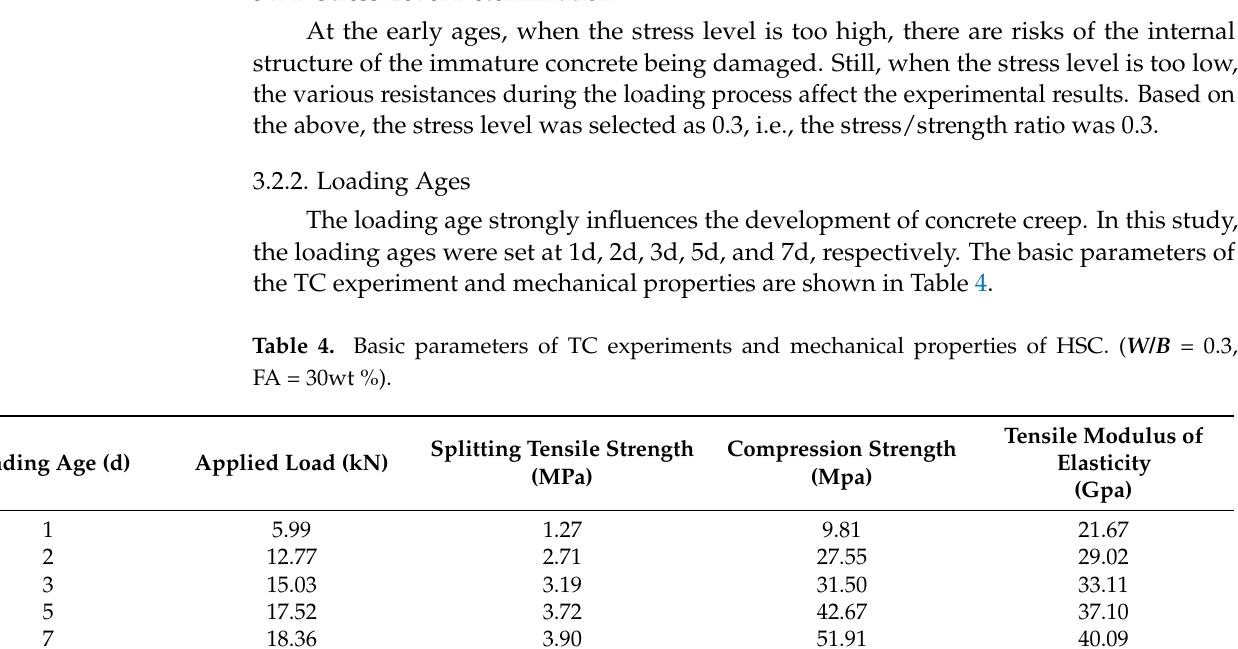
Table 3. Mix Proportion of HSC with 30wt % FA (kg/m 3 ).